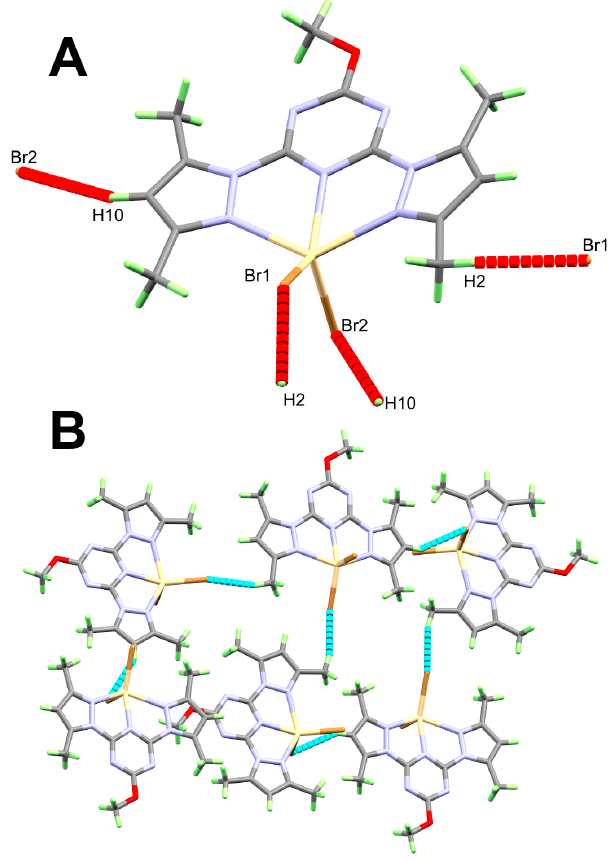
Table 3. Hydrogen-bond parameters in the [Cd(BPMT)Br 2 ] complex.